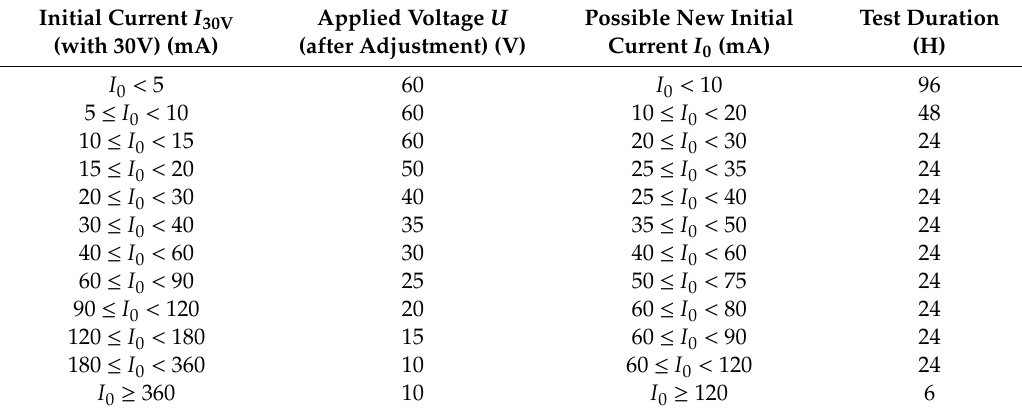
Table 3. Test voltage and duration for concrete with normal binder content [59].